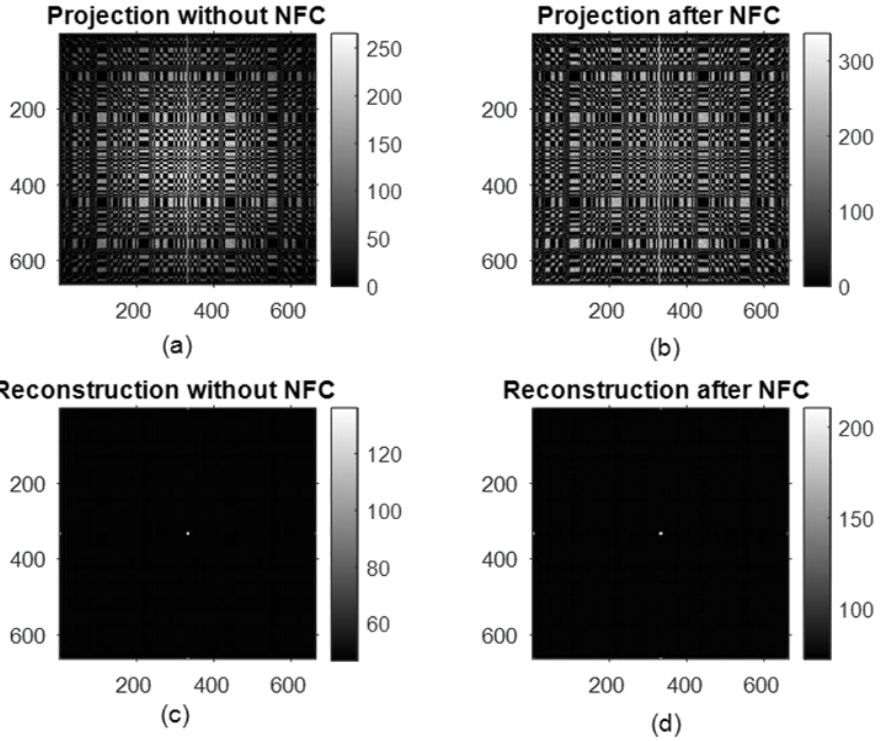
Figure 5. Projection of the simulated point source ( a ), corrected projection after near-field correction ( b ), reconstructed image of the point source without correction ( c ) and with correction ( d ).